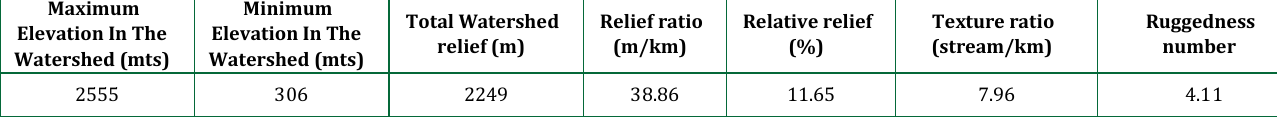
Table 3: Topographic properties of Abbasan watershed